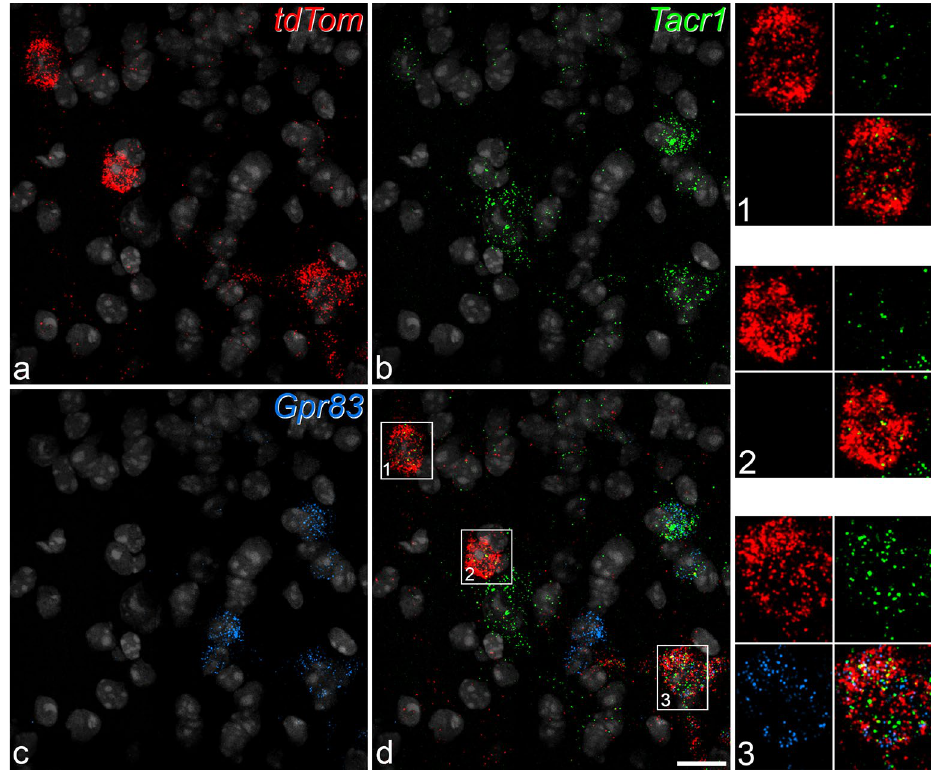
Figure 6. Fluorescence in situ hybridisation with RNAscope in a horizontal section from a Phox2a::Cre;Rosa26 LSL-tdTomato mouse. The section was reacted with probes for tdTom (red), Tacr1 (green) and Gpr83 (blue) mRNAs, and these are shown separately in ( a – c ) and combined in ( d ). The nuclear counterstain NucBlue is shown in grey. Three tdTom -positive cells are present (numbered 1–3 in ( d )). These are illustrated at higher magnification in the insets, and in each of these the top row shows labelling for tdTom and Tacr1 and the bottom row labelling for Gpr83 together with a merged image. All 3 cells are positive for Tacr1 (based on the presence of more than 5 transcripts), while cell 3 is positive for Gpr83 . Note that there are sparse scattered transcripts for tdTom , which are also seen in Rosa26 LSL-tdTomato mice, and presumably result from a low-level “leak” of tdTomato expression. However, these can easily be distinguished from the labelling in the putative Phox2a-positive lamina I neurons. Images are projections of confocal optical sections (1 μm z-separation) through the full thickness of the section. Scale = 20 μm.